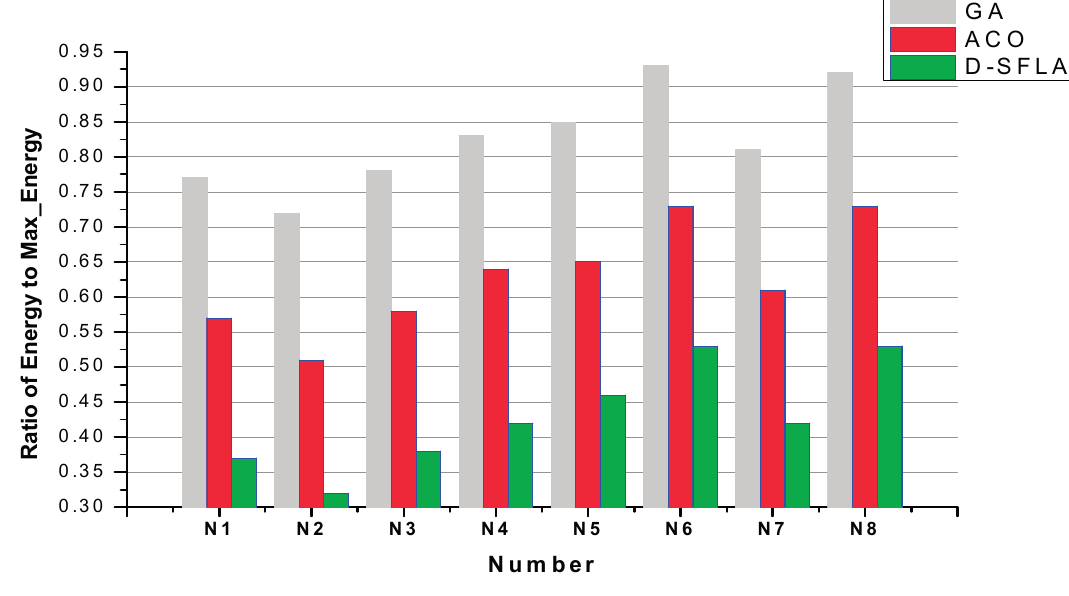
Figure 9. The energy consumption of GA, ACO and D-SFLA for e - RTSP